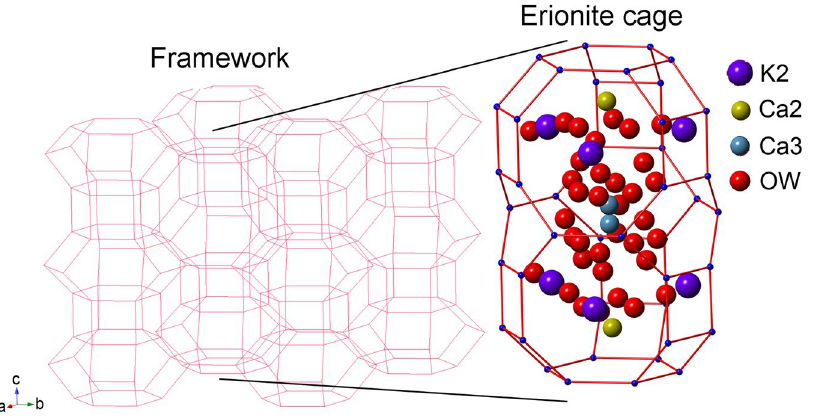
Figure 1. Drawing of (left) the framework of the K-exchanged form of erionite and of (right) the EF cations and water molecules location within the erionite cage. H 2 O residing at OW sites may be partly replaced by K